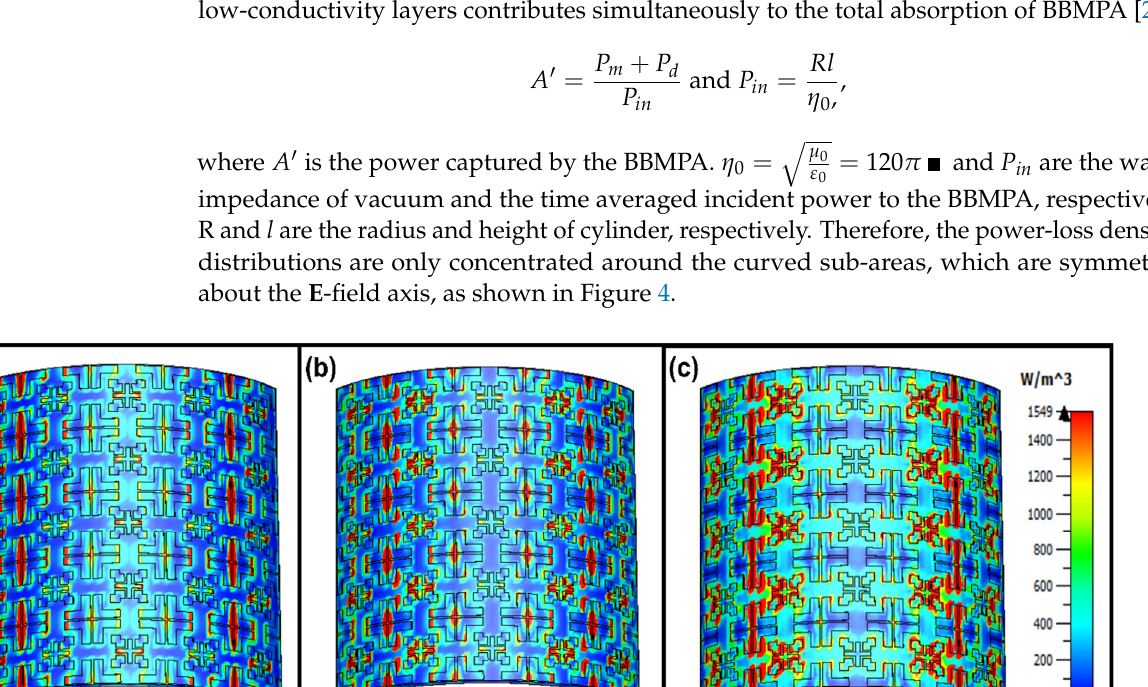
Figure 3. Three-dimensional distribution of the magnetic-energy density in the dielectric layer ( top ) and the surface power- loss one ( bottom ) of MPA structure at ( a ) 9.2, ( b ) 13.0, and ( c ) 18.2 GHz (for the TE polarization).